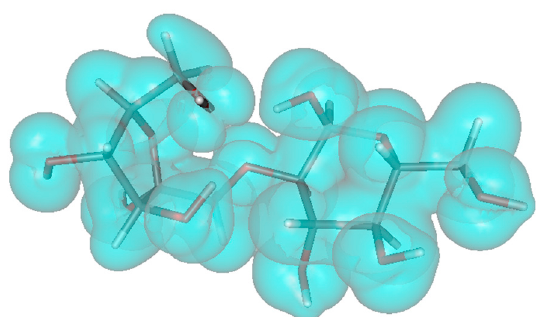
Figure 5. An electronic density representation of the molecular structure of sucrose. In this model, sticks represent bondings between carbon, hydrogen and oxygen atoms. The electron clouds is depicted around each atom. Red: Oxygen, white: Hydrogen and blue: Carbon.